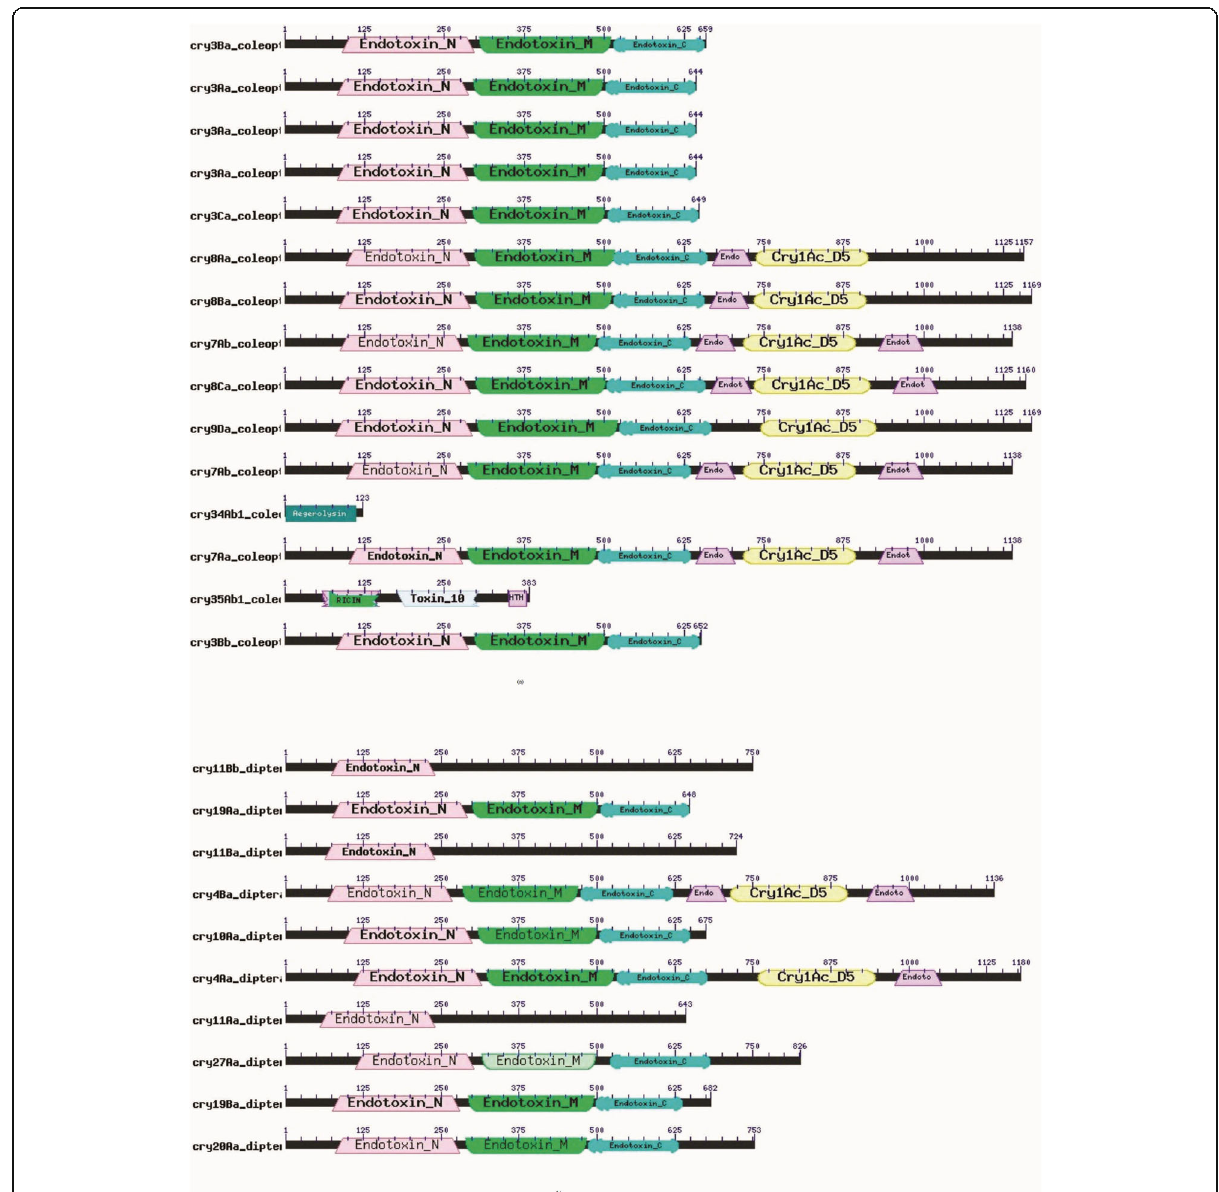
Fig. 1 a NCBI batch conserved domain-search result for Coleoptera insect order. b NCBI batch conserved domain-search for Diptera insect